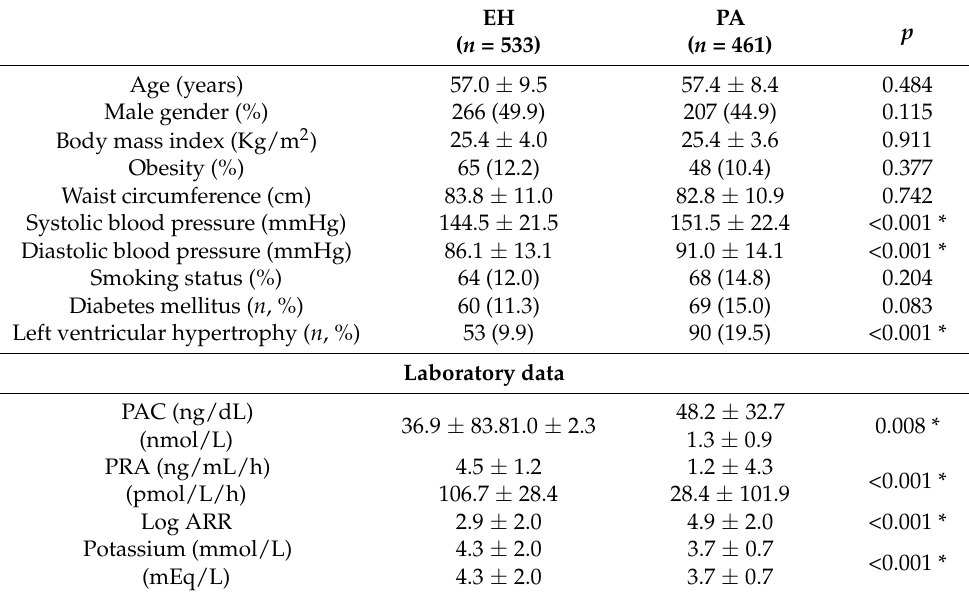
Table 1. Demographic characteristics of